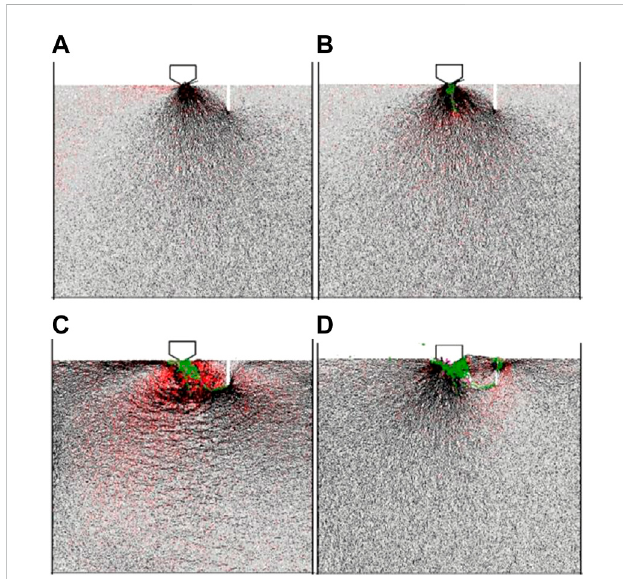
FIGURE 7 Simulation of the failure evolution process of different trajectory cutting models (A) 0.1 mm (B) 0.15 mm (C) 0.2 mm (D) 5